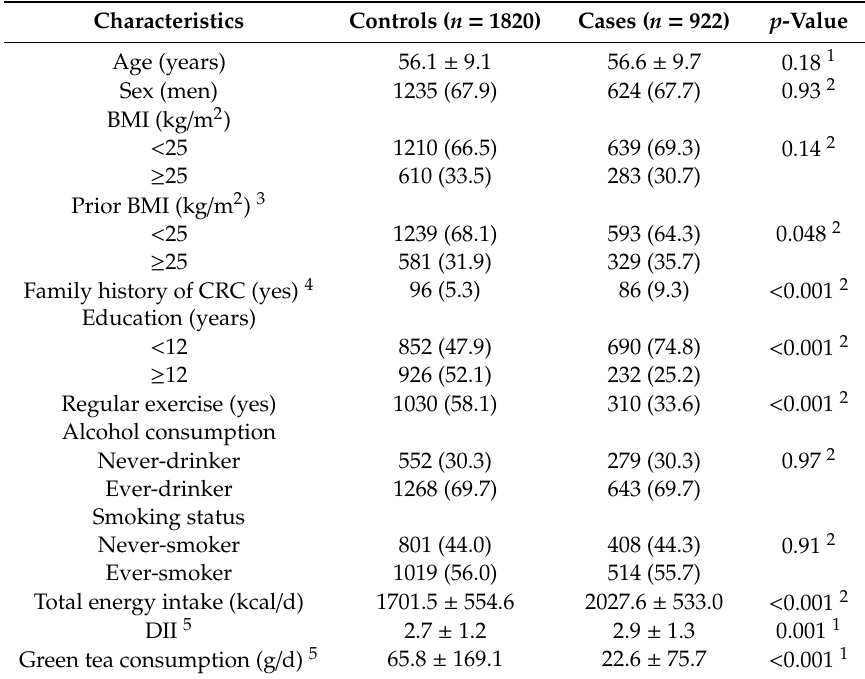
Table 1. General characteristics of the study population.